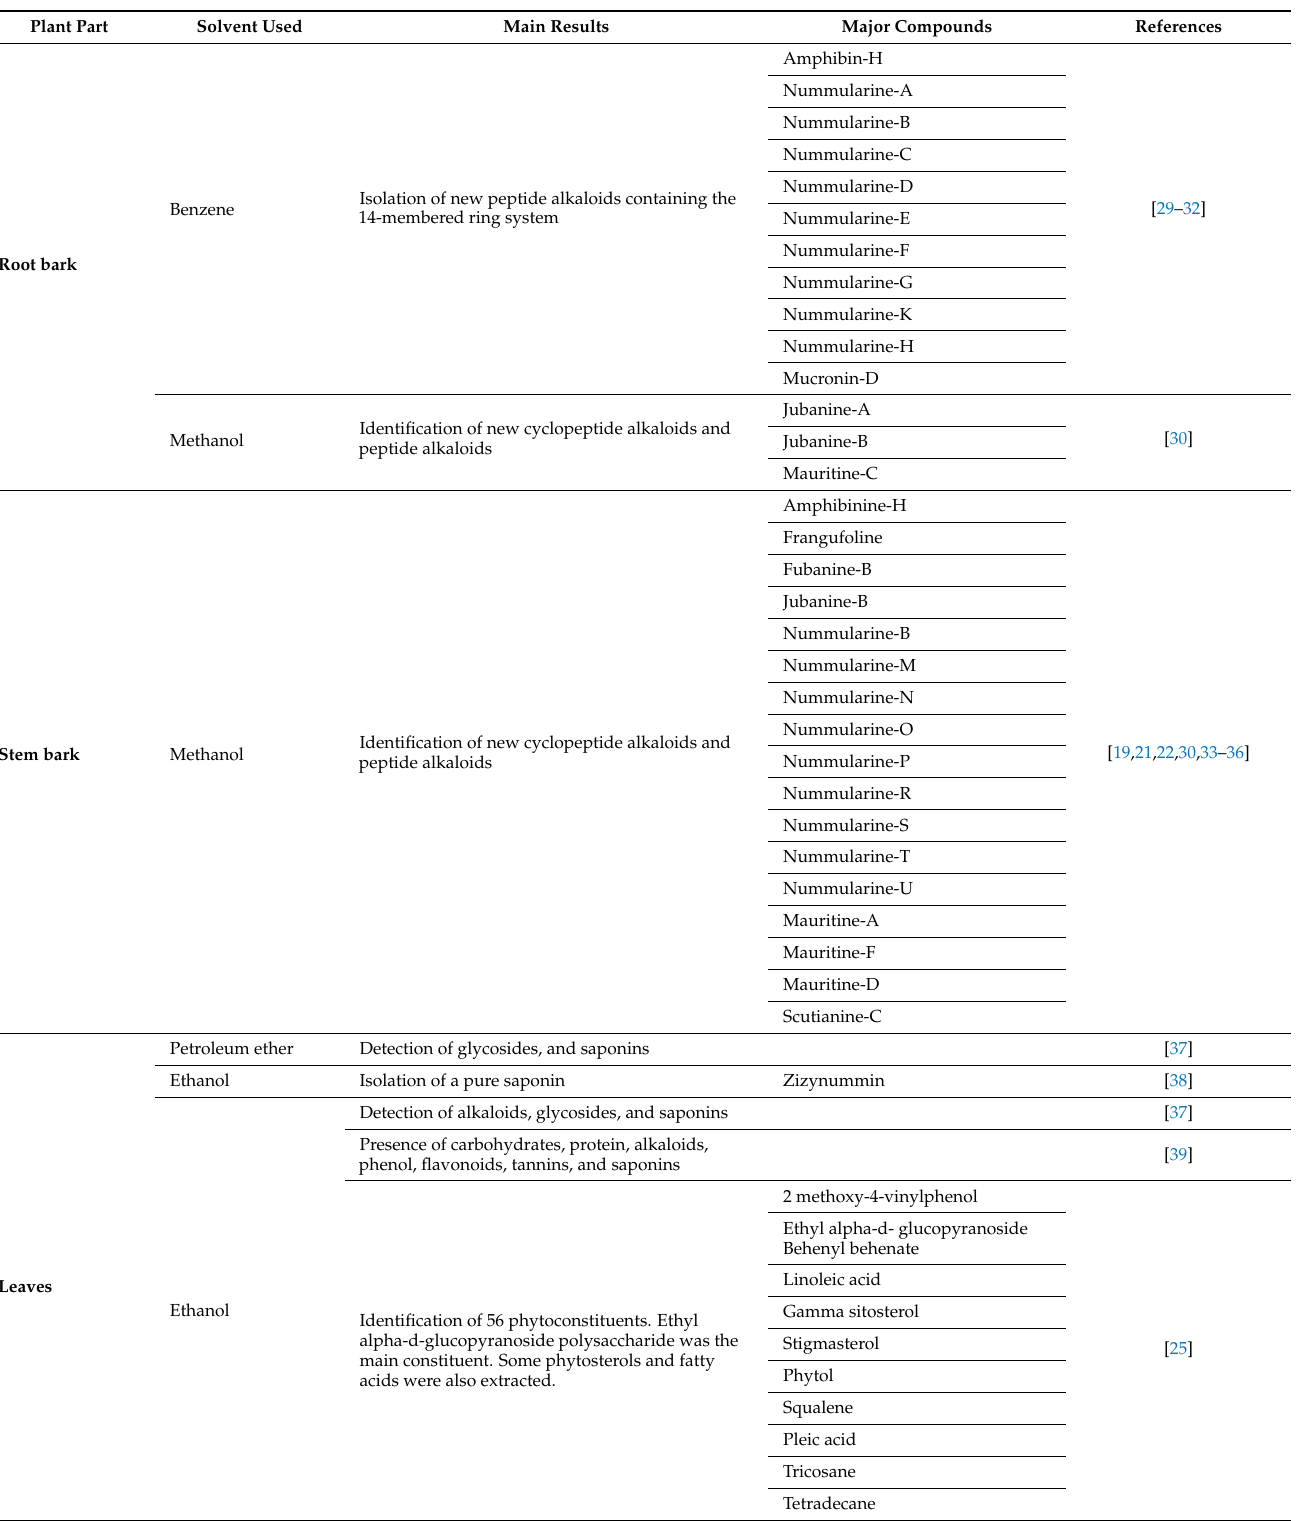
Table 1. Summary of the phytochemical composition of extracts from different parts of the Zizyphus nummularia, using different